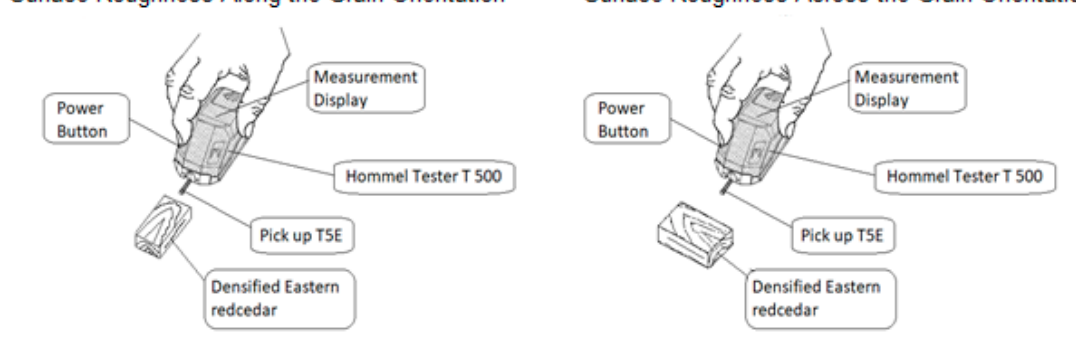
Figure 4. Surface roughness measurement test.